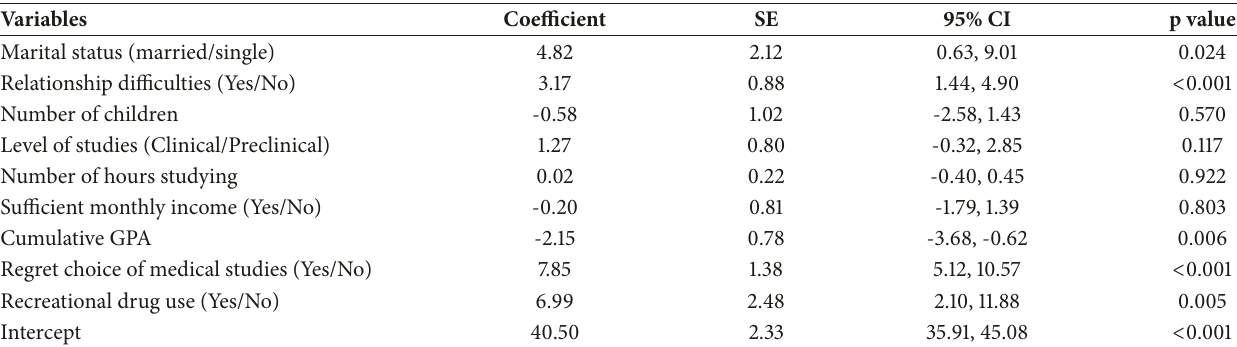
Table 4: Multivariable linear regression analysis of potential determinants of burnout syndrome amongst 413 medical students who were assessed for burnout syndrome from January to March 2018 in Cameroon.